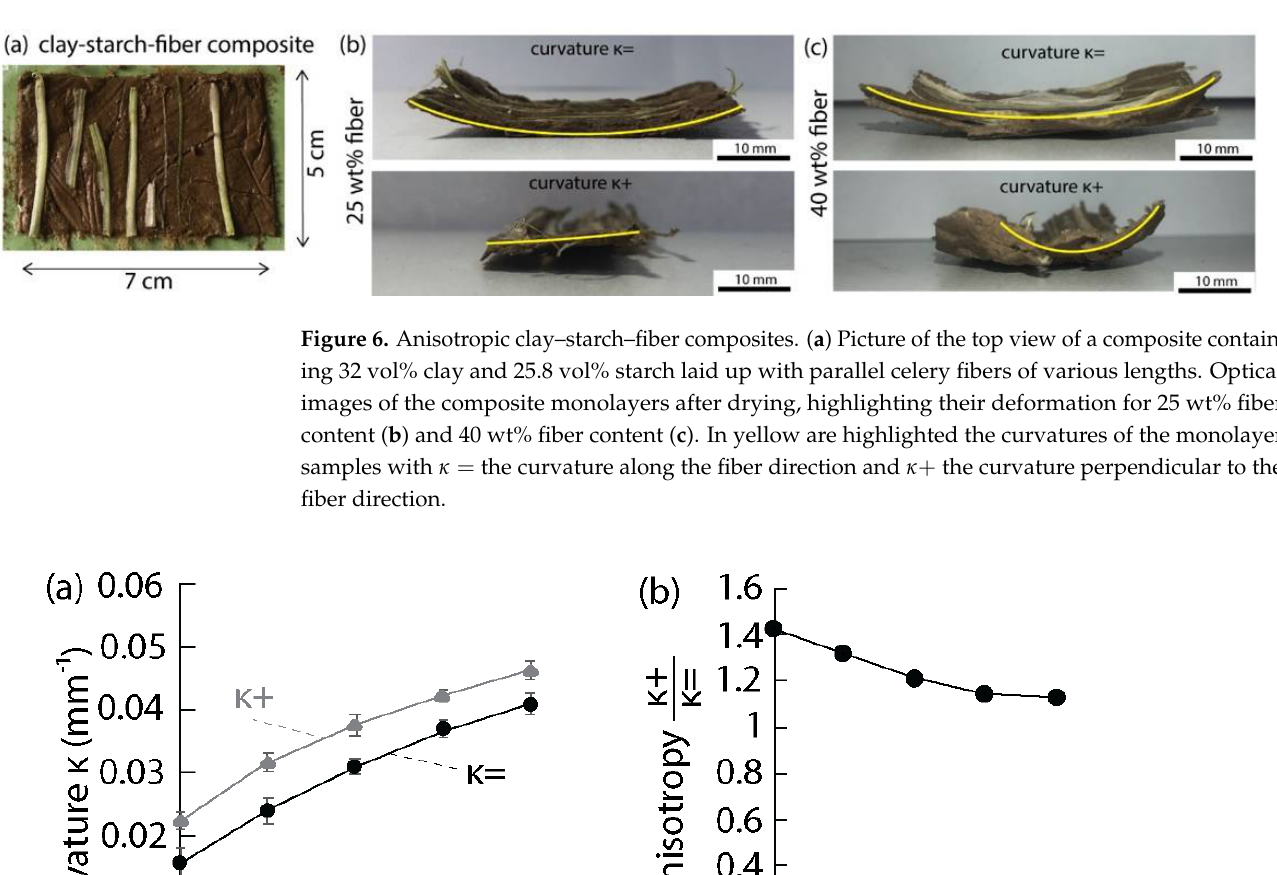
Figure 6. Anisotropic clay–starch–fiber composites. ( a ) Picture of the top view of a composite con- taining 32 vol% clay and 25.8 vol% starch laid up with parallel celery fibers of various lengths. Op- tical images of the composite monolayers after drying, highlighting their deformation for 25 wt% fiber content ( b ) and 40 wt% fiber content ( c ). In yellow are highlighted the curvatures of the mon- olayer samples with (cid:2018) = the curvature along the fiber direction and (cid:2018) + the curvature perpendic- ular to the fiber direction.